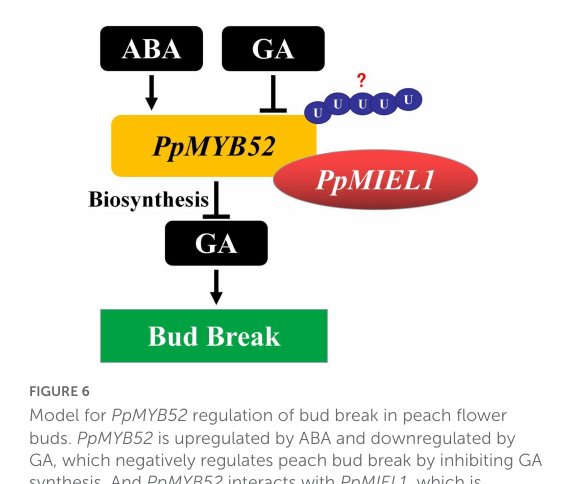
FIGURE6 Model for PpMYB52 regulation of bud break in peach flower buds. PpMYB52 is upregulated by ABA and downregulated by GA, which negatively regulates peach bud break by inhibiting GA synthesis. And PpMYB52 interacts with PpMIEL1 , which is upregulated in the process of bud break and may positively regulate peach bud break by ubiquitination-mediated degradation of PpMYB52